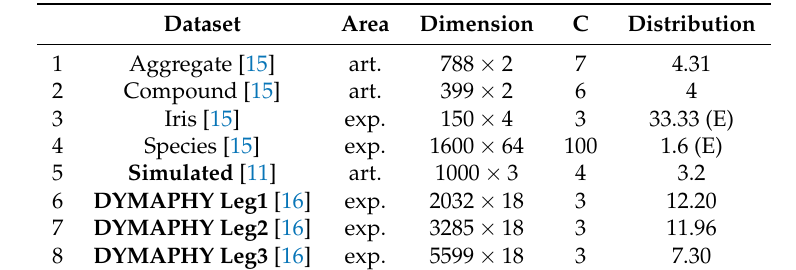
Table 1. Dataset characteristics:name, area:exp. = experimental and art. = artificial, dimension (N observations × D features), number of classes C , distribution: the distribution percentage of the smallest class, (E) if equal. In bold: Time Series